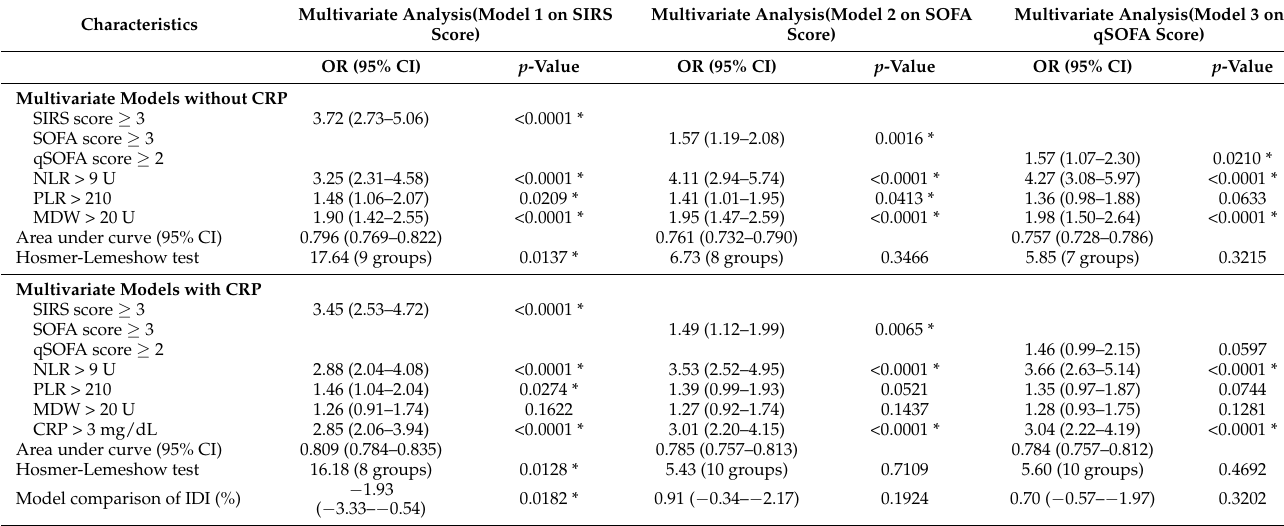
Table 3. Primary Outcome: the Scoring Systems and Laboratory Tests for Predicting Sepsis (Multivariate).